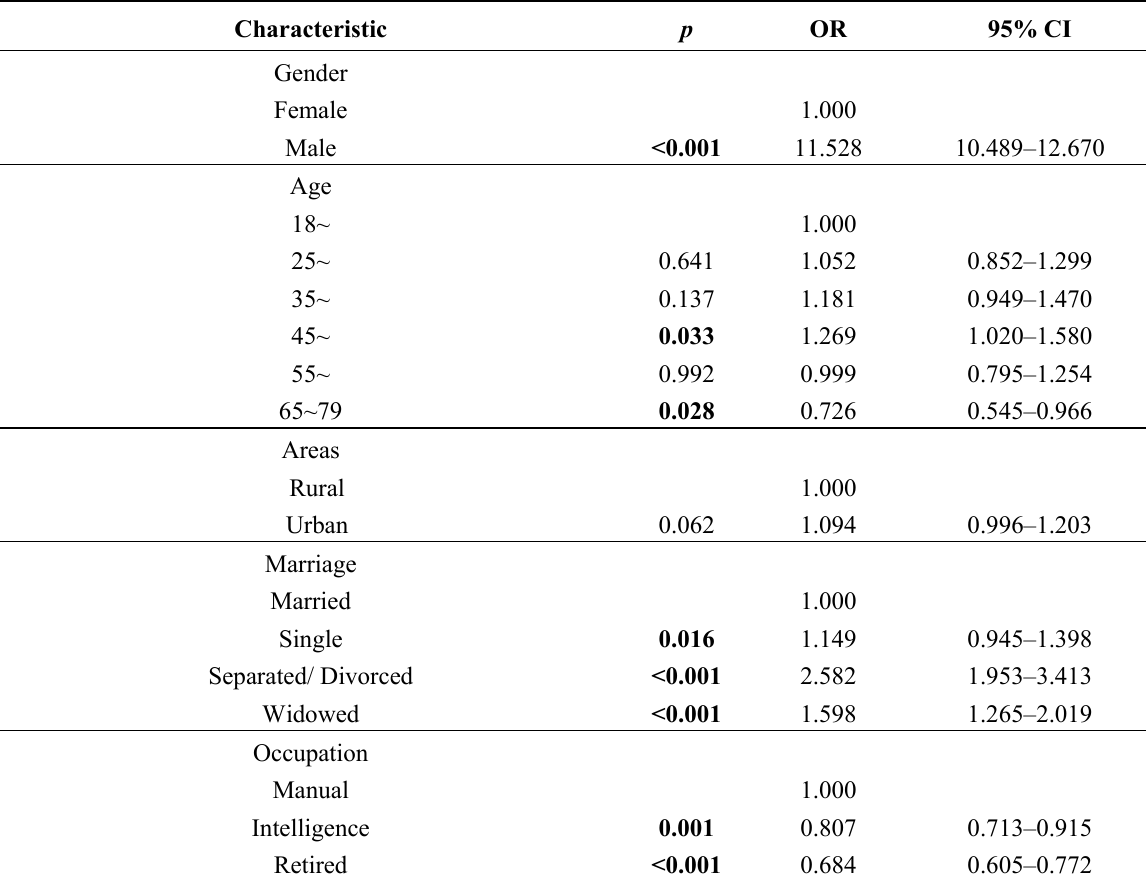
Table 4. Multivariate analysis of risk factors associated with current smoking among adults from Jilin Province, China in